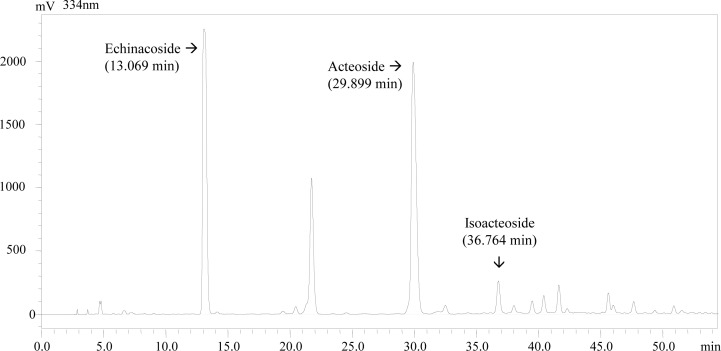
A representative chromatogram and UV spectrum of PRE at 334 nm.The mobile phases were acetonitrile and water containing 0.1% phosphoric acid (v/v) with a gradient elution at a flow rate of 1.0 ml/min.